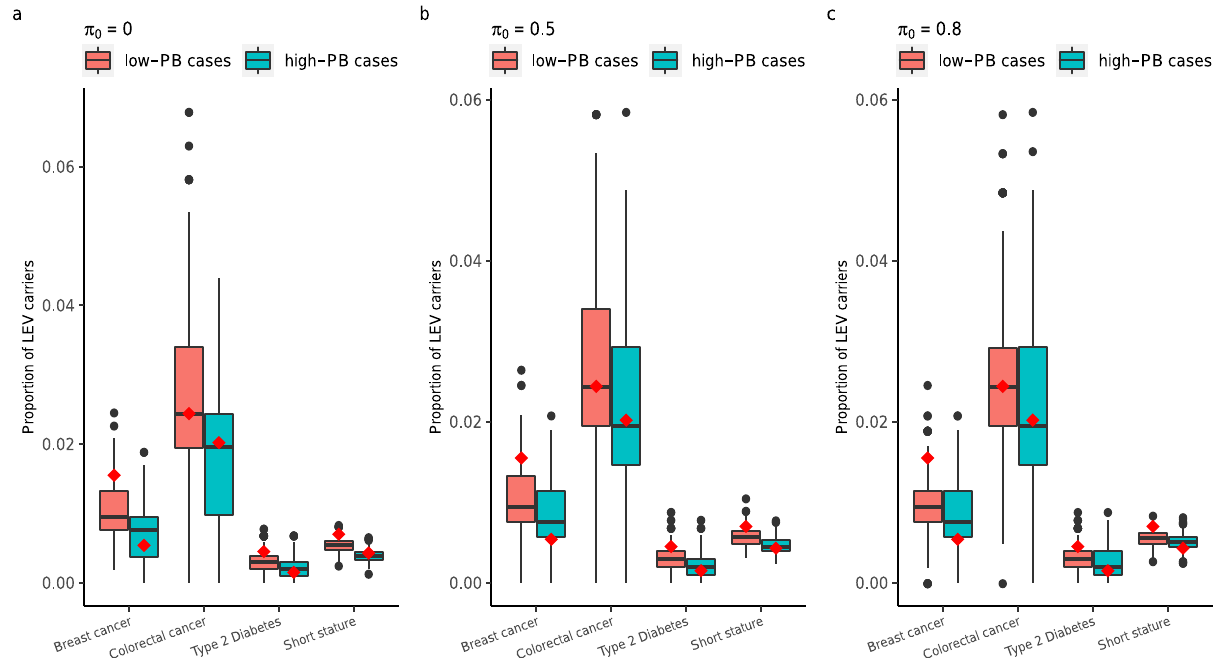
Fig. 8 Prediction of the framework on proportion of LEV carriers in cases with a given PB pro fi le matches empirical observations, providing an LEV screening approach. Using empirically-informed values (i.e., derived from the UK Biobank) of the parameters (including the common variant-based heritability; disease prevalence; allele frequency and odds ratio of the LEV), we performed simulations for four traits under the genetic architecture in line with negative selection. We varied the π 0 (the proportion of noncausal variants in the polygenic risk score) at a 0, b 0.5, and c 0.8. Cases were de fi ned under the liability-threshold model and classi fi ed into “ low-PB ” and “ high-PB ” (using the median as the cutoff) groups. The proportion of LEV carriers in each group was estimated as the number of cases carrying the LEV divided by the total number of cases. The distribution of the proportion (across 500 simulated sets) is shown in the boxplot. The median of the proportion is visualized as a black segment in the middle of the box. The lower and upper hinges correspond to the fi rst and third quartiles (the 25th and 75th percentiles). The upper/lower whisker extends from the hinge to the largest/smallest value no further than/at most 1.5 * IQR from the hinge (where IQR is the inter-quartile range or the distance between the fi rst and third quartiles). The actual observed proportion of LEV carriers for each PB pro fi le from empirical data (with matching parameters as the simulations) is marked as a red diamond. Thus, the prediction of the framework and the empirical dataset (with matching parameters as the simulations) were concordant. Source data are provided as a Source Data fi